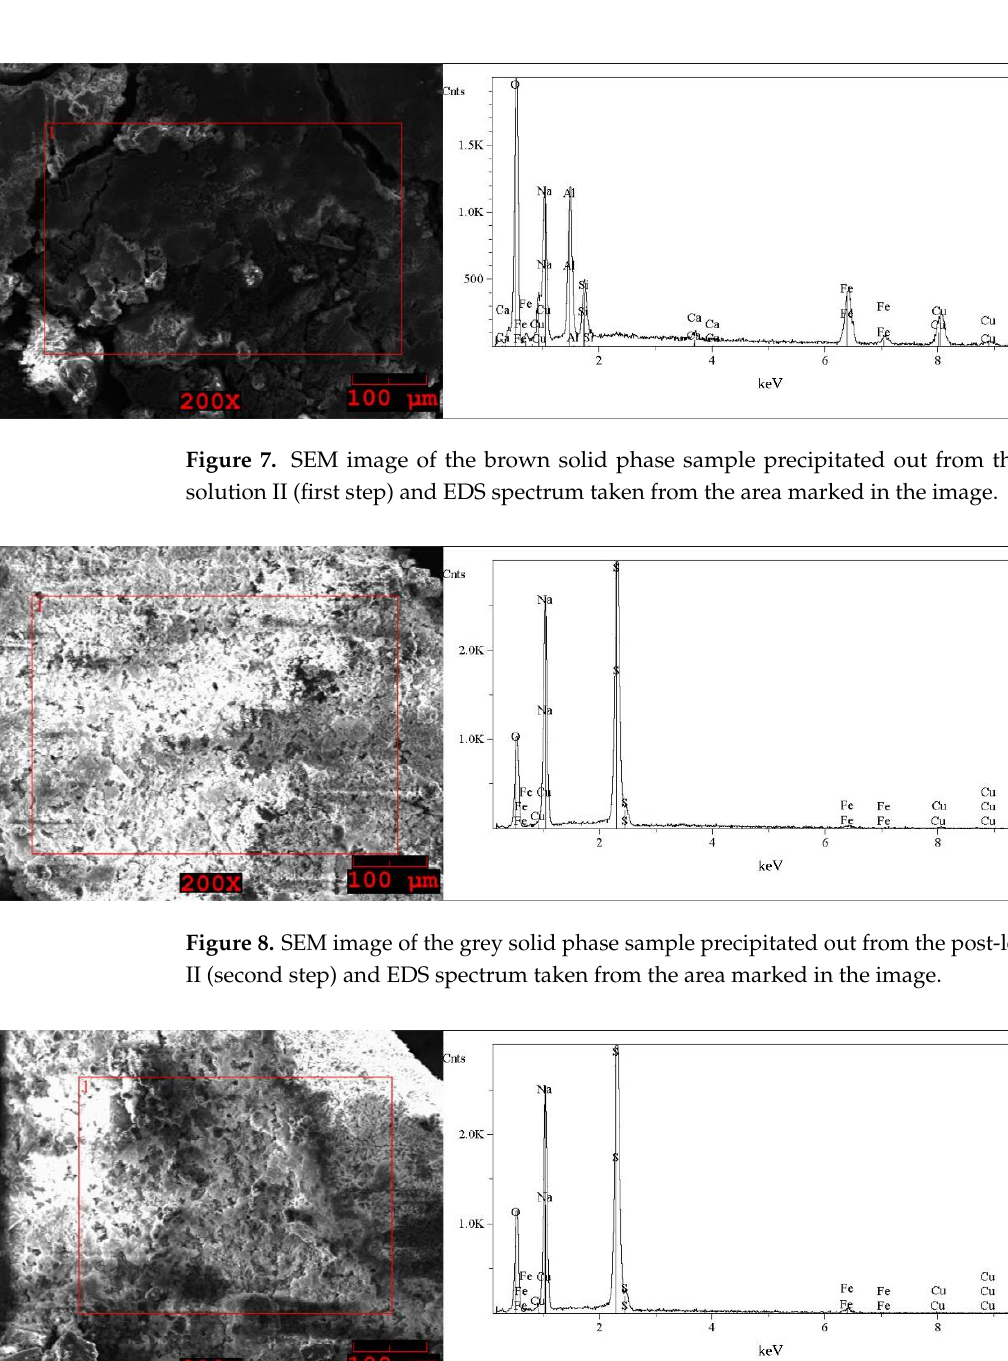
Figure 6. SEM image of the white solid phase sample precipitated out from the post-leaching solu-